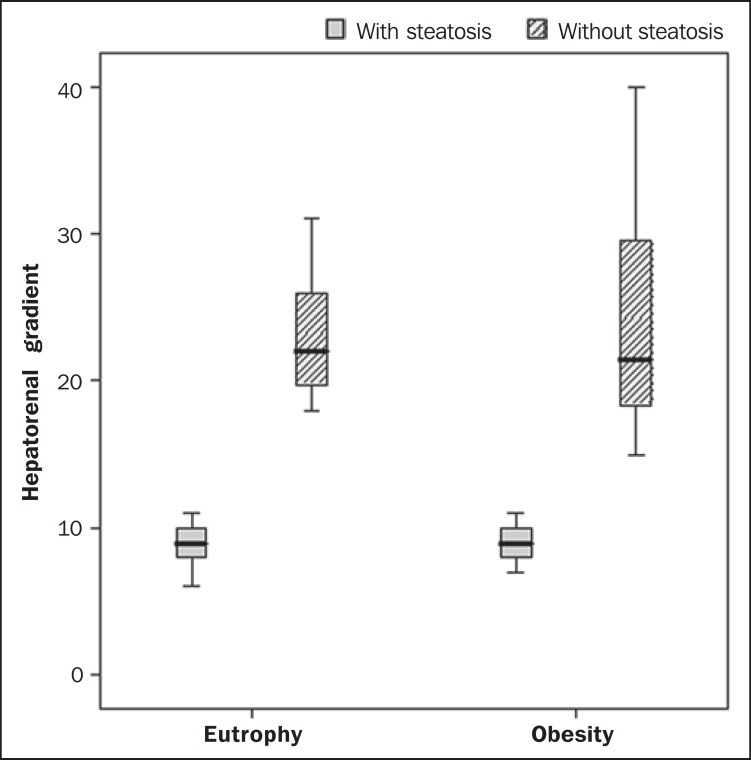
Box plot depicting gradient values (levels) between groups of individuals with and
without steatosis. The central line within the box represents the median. The
upper and lower limits of the box represent respectively the 75th and 25th
percentiles. The upper and lower error bars represent the median ± 1.5
(P75–P25).